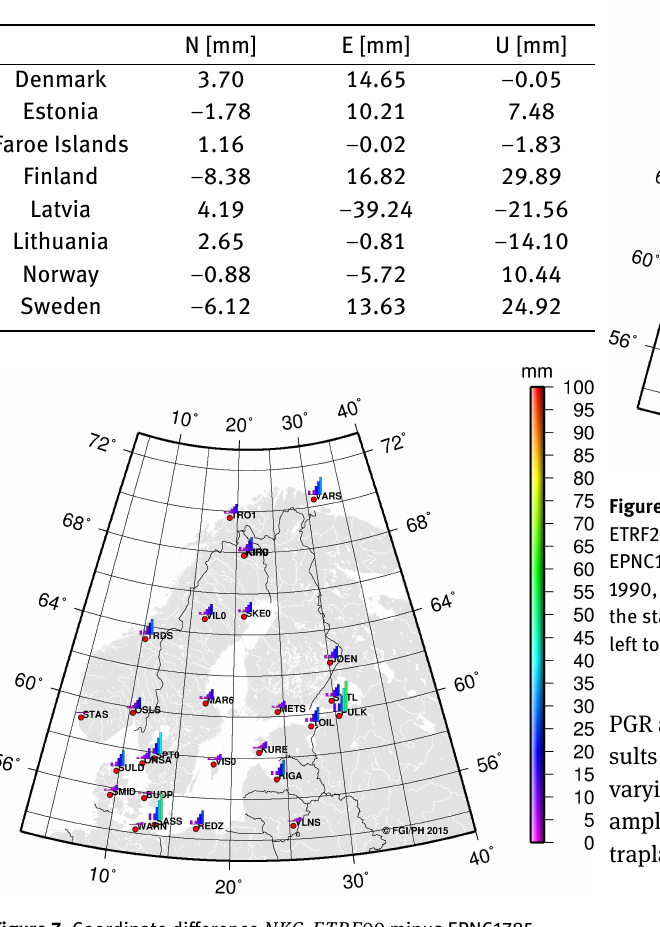
Table 5: Averages of the coordinate differences NKG ETRF 00 mi- nus national ETRS89 coordinates.